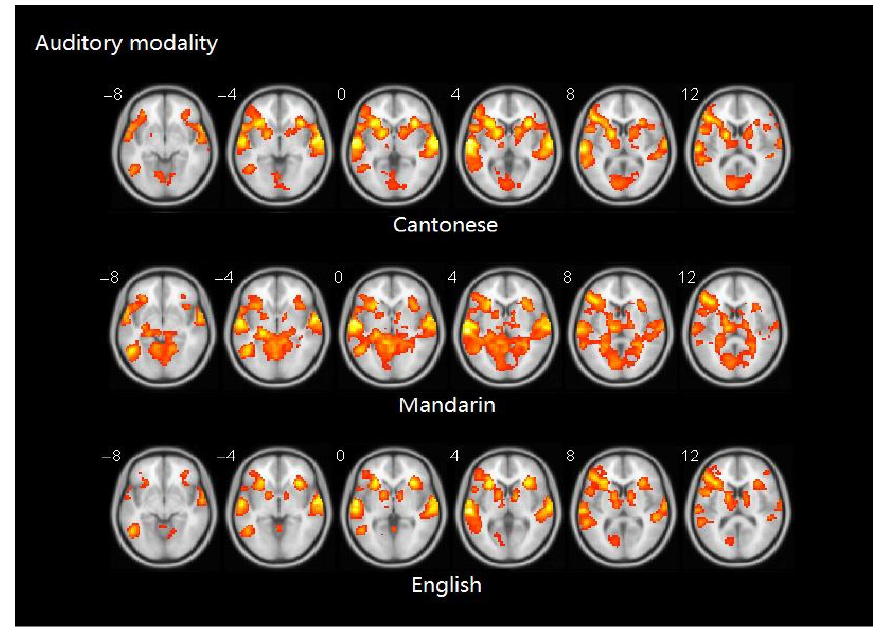
Figure 6. Brain activity maps of Cantonese, Mandarin, and English in auditory